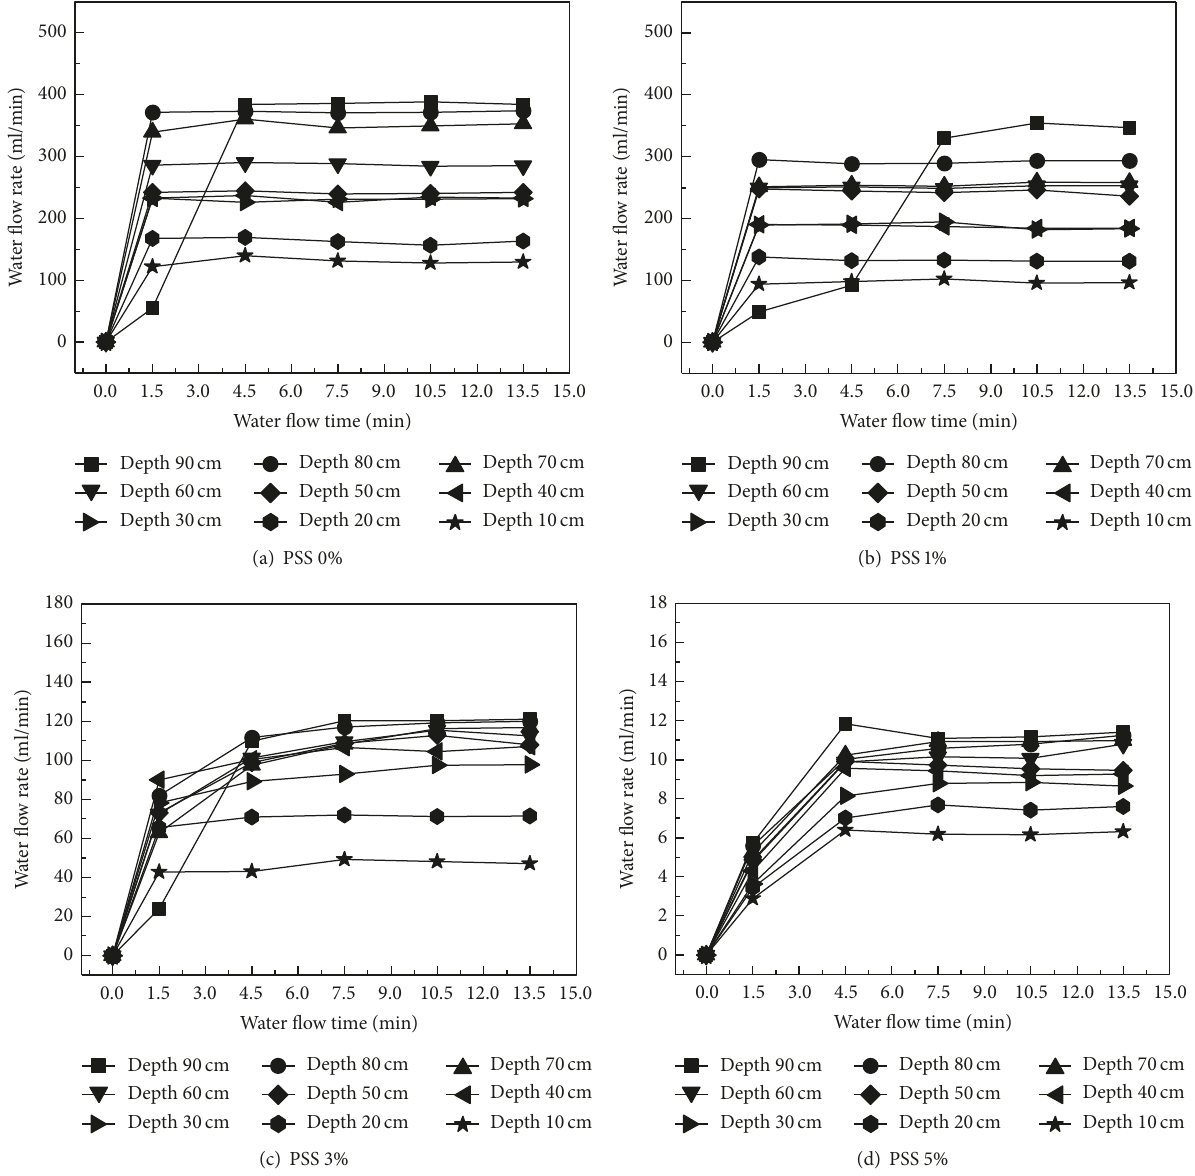
Figure 13: The water flow rate ( 𝐹 ) of different depth in specimens reinforced with different PSS concentrations.